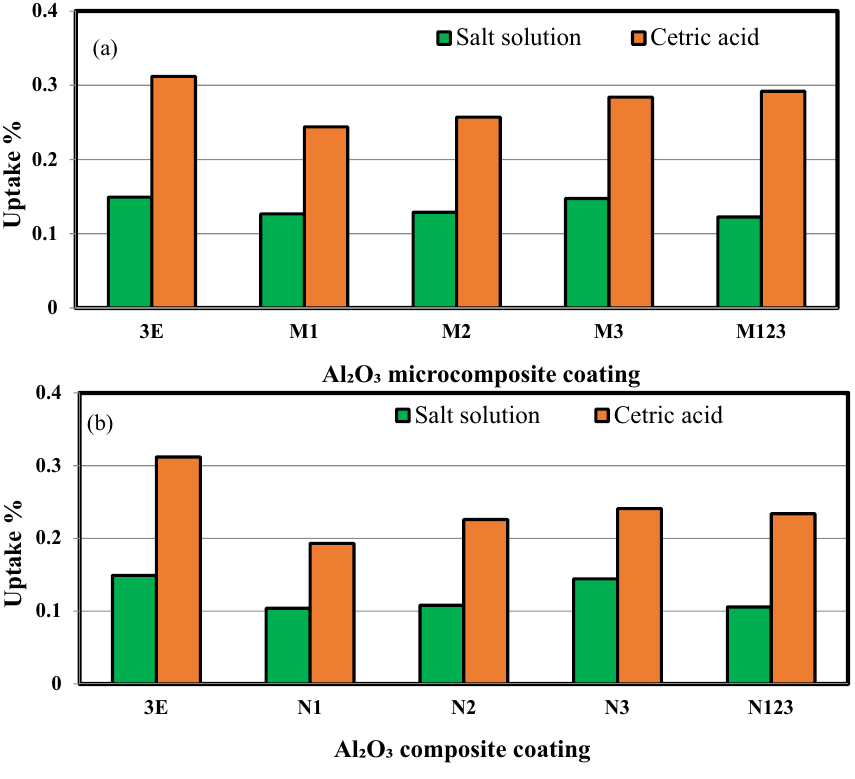
Figure 8. The barrier properties of multilayers epoxy coating to steel substrate filled with Al 2 O 3 micro/ nanoparticles immersed for 35 days in ( a ) salt solution ( b ) citric